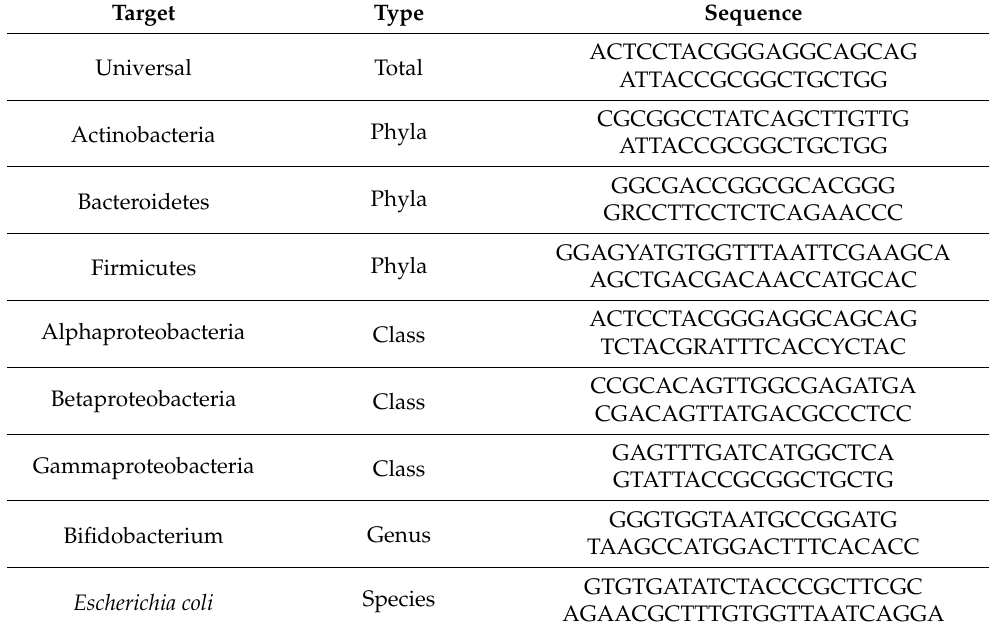
Table 1. Bacterial primer sequences.